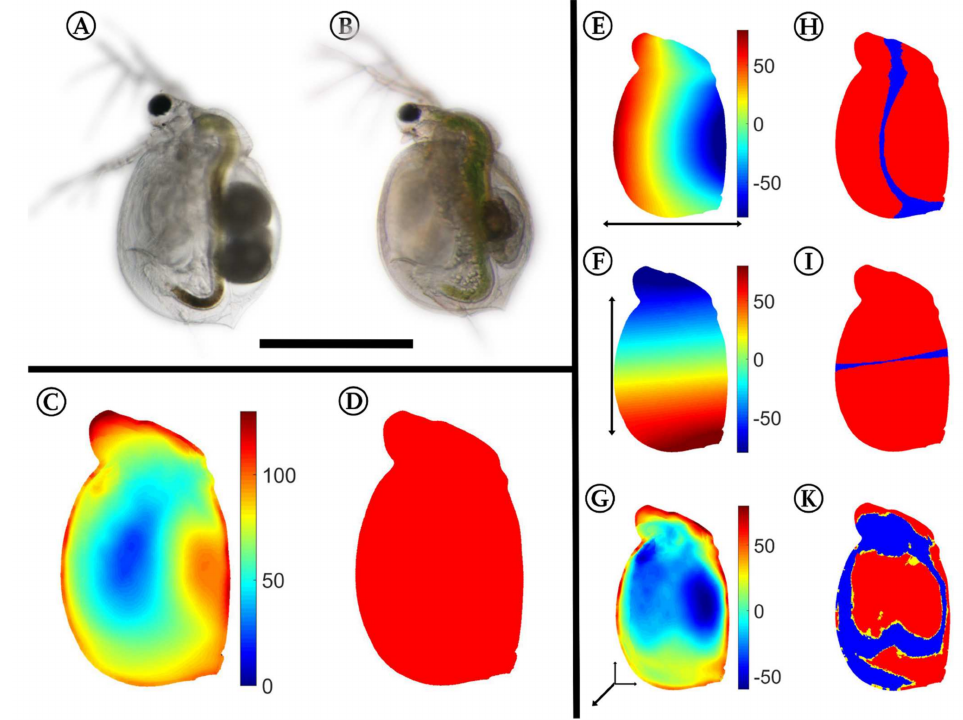
Figure 2. 3D analysis of morphological alterations between control and Utricularia -exposed C. dubia . Control ( A ) and Utricularia -exposed C. dubia ( B ) of same age, scale bar = 1 mm. All subsequent analyses are projected on the average Utricularia -exposed animal. ( C ) Overall deformation; strong shifts are colored in shades of red, while small or no changes are indicated by shades of blue. ( D ) Confidence ellipsoid plot, revealing no overlapping confidence ellipsoids. ( E , F ) Here, shades of red indicate a shift in positive direction on that axis (dorsal/anterior/distal), shades of blue indicate a shift in negative direction on the respective axis (ventral/posterior/proximal). Shifts along the anterior–posterior ( E ) and dorso–ventral axis ( F ) show that the animals are smaller in the Utricularia - exposed morph. The deformation in the lateral dimension ( G ) gives regions of reduced and increased body width. Most of the found shifts are proven significant with respective Wilcoxon tests and FDR-based q-values ( H , I , K ). These figures give regions with p -values of respective Wilcoxon tests lower than 0.01 colored yellow, regions that also showed q-values lower than 0.001 are colored red. For the respective analysis, all samples of both treatments were taken into account (n induced = 8, n control =